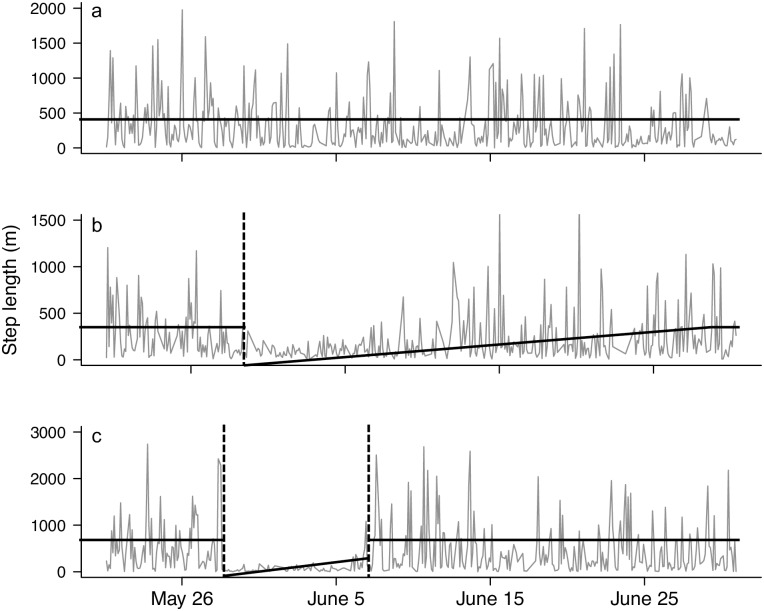
Examples of a priori movement models used in an individual-based method to infer parturition and calf mortality events in female woodland caribou (Rangifer tarandus caribou) (sensu 8) and actual movement characteristics of female caribou.Gray line indicates the movement pattern of female. Black line indicates the predicted mean step length from movement model. The movement data used to generate the movement patterns were collected from either Fogo Island herd (a and b) or Middle Ridge herd (c). (a) No parturition event occurred, this is indicated by no break point in the mean movement rate. (b) Parturition event occurred on approximately 29 May and no mortality event occurred (prior to four weeks of age), this is indicated by a single break point in mean movement rate followed by a gradual increase in movement rate until mean movement rate reaches that of pre-parturition (at approximately four weeks post-parturition). (c) Parturition event occurred on approximately 28 May then a calf mortality event occurred on approximately 6 June, this is indicated by two break points in mean movement rate, one at the point of parturition and subsequently when the female lost her calf before four weeks and immediately returns to pre-parturition movement rate.